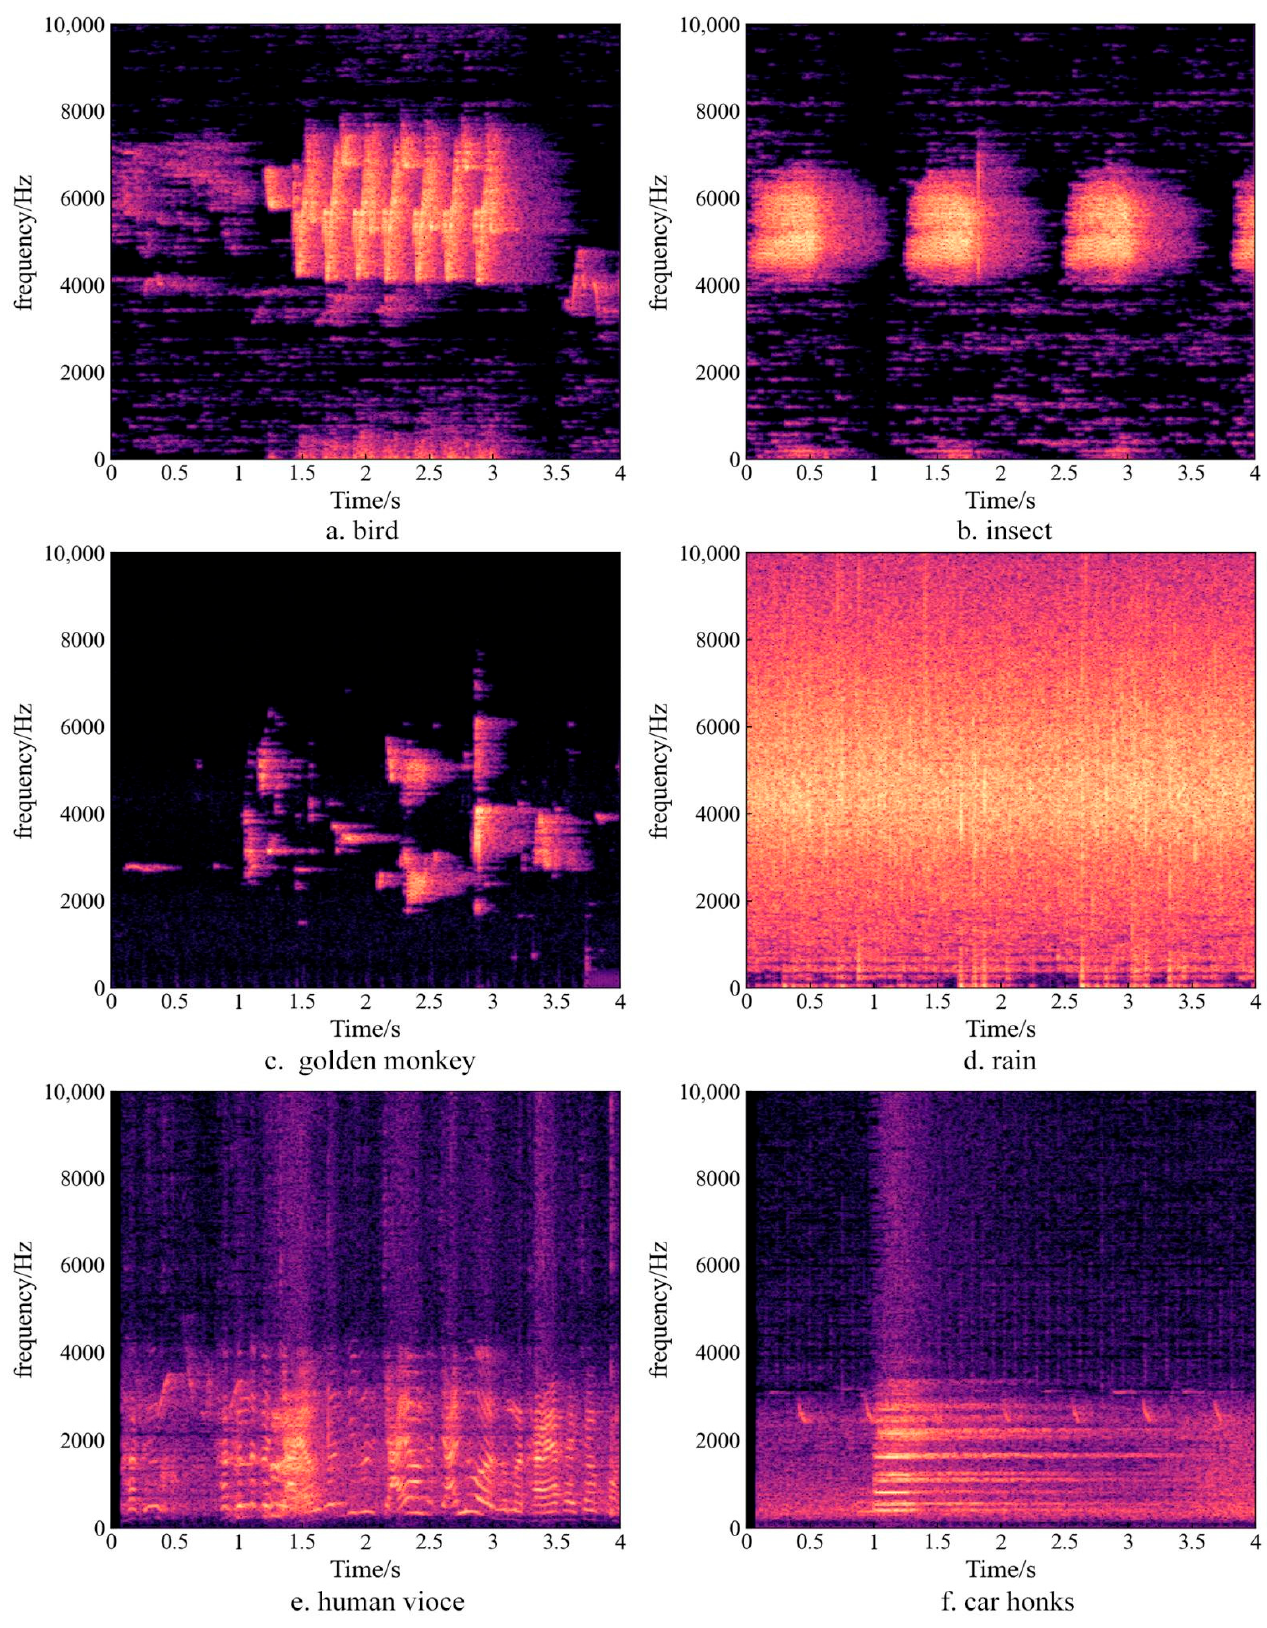
Figure 4. Different frequency characteristics of sounds from different sources: ( a – f ).